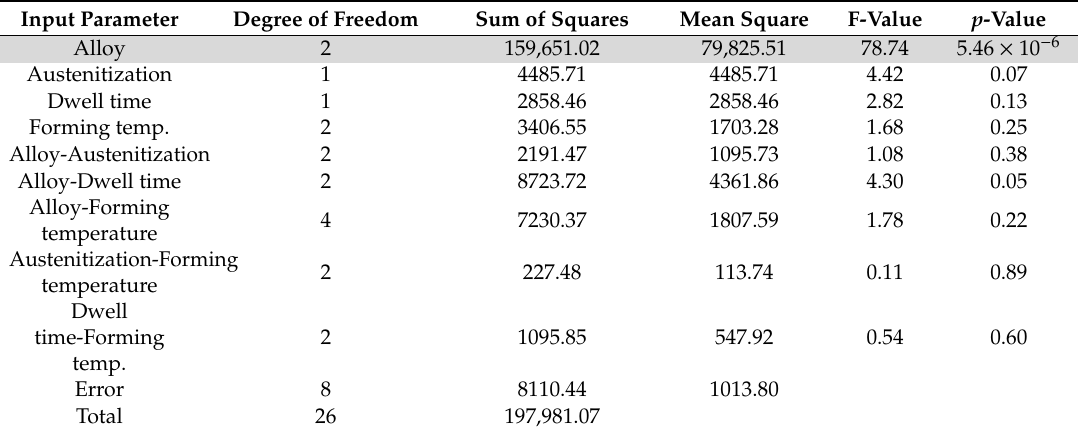
Table 6. ANOVA results for the resulting Vickers hardness under consideration of the dwell time. Input Parameter Degree of Freedom Sum of Squares Mean Square F-Value p